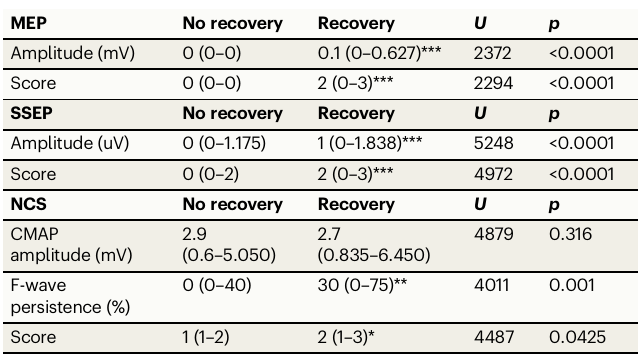
Table 1 | Outcome of electrophysiological examinations at